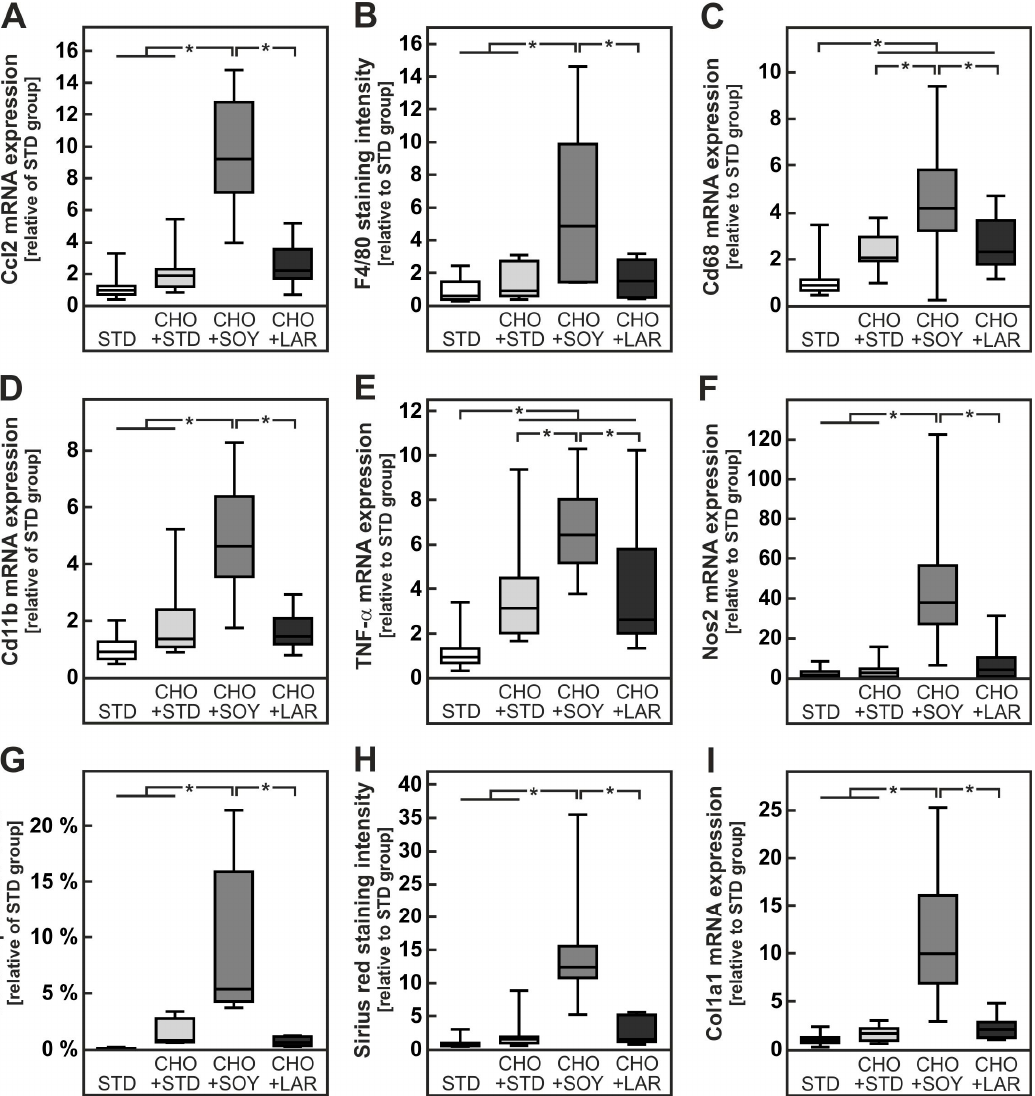
Figure 5. Enhanced macrophage infiltration, inflammation, apoptosis and fibrosis in mice fed a CHO + SOY diet. Mice received the diets for 20 weeks. ( A ) Relative mRNA expression of the chemokine Ccl2 (alternative name Mcp-1) in mice liver. ( B ) Quantification of F4/80-stained microphotographs of the liver. ( C , D , E , F ) Relative mRNA expression of the macrophage markers Cd68 ( C ) and Cd11b ( D , gene name Itgam ), the cytokine tumor necrosis factor α (TNF- α , E ) and the enzyme inducible nitric oxide synthase 2 ( F , alternative name iNos) in mice liver. ( G ) Quantification of hepatocyte apoptosis by TUNEL assay. ( H ) Quantification of Sirius Red-stained microphotographs of the liver calculated by dense intensity of Sirius Red relative to the amount of cytosolic background per field in 5 randomly chosen microphotographs per liver section. ( I ) Relative mRNA expression of the fibrosis marker collagen 1a1 (Col1a1) in mice liver. Values are median (line), upper- and lower quartile (box) and extremes (whiskers) of 17–35 ( A , C , D , E , F , I ), 4–7 ( B , G ) or 13–16 ( H ) mice per group. Statistics: One-way-ANOVA with Tukey’s post hoc test for multiple comparisons. *: p < 0.05.